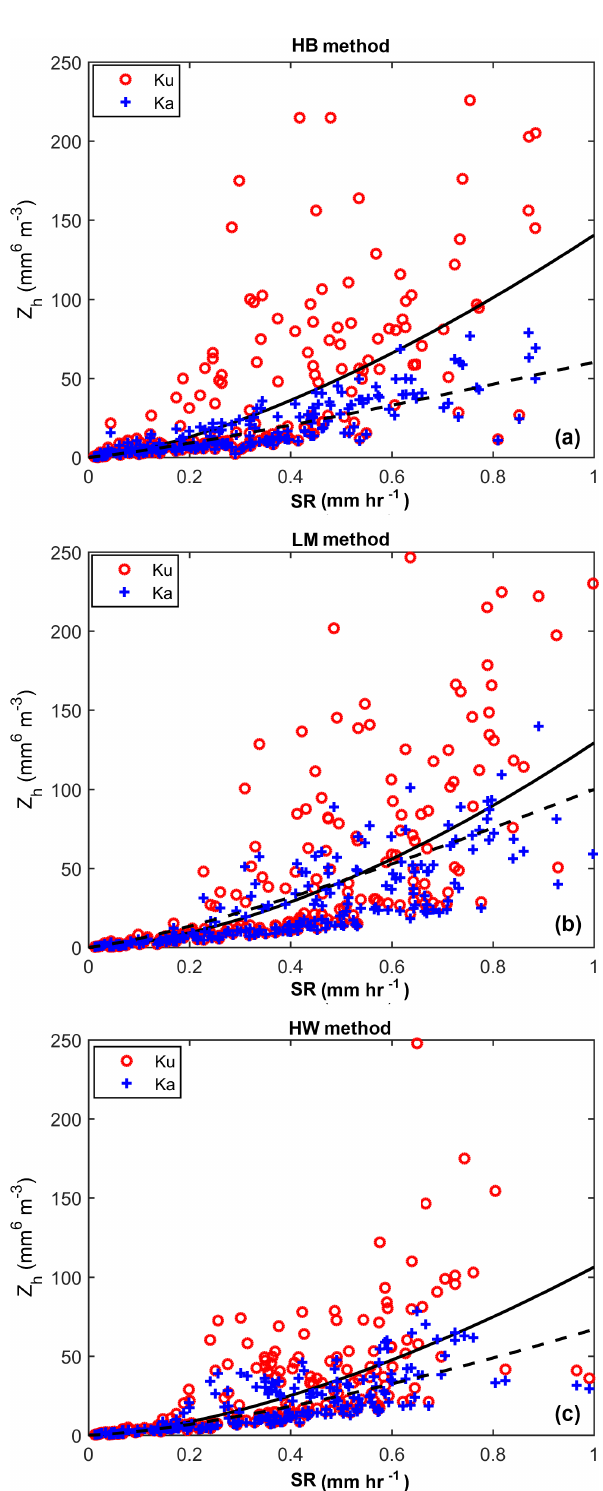
Figure 13. 2DVD-derived Z h vs. 2DVD-measured SR scatterplots, with Z –SR power-law fits, for Ku- and Ka-bands and the HB method (a) , LM method (b) , and HW method (c)